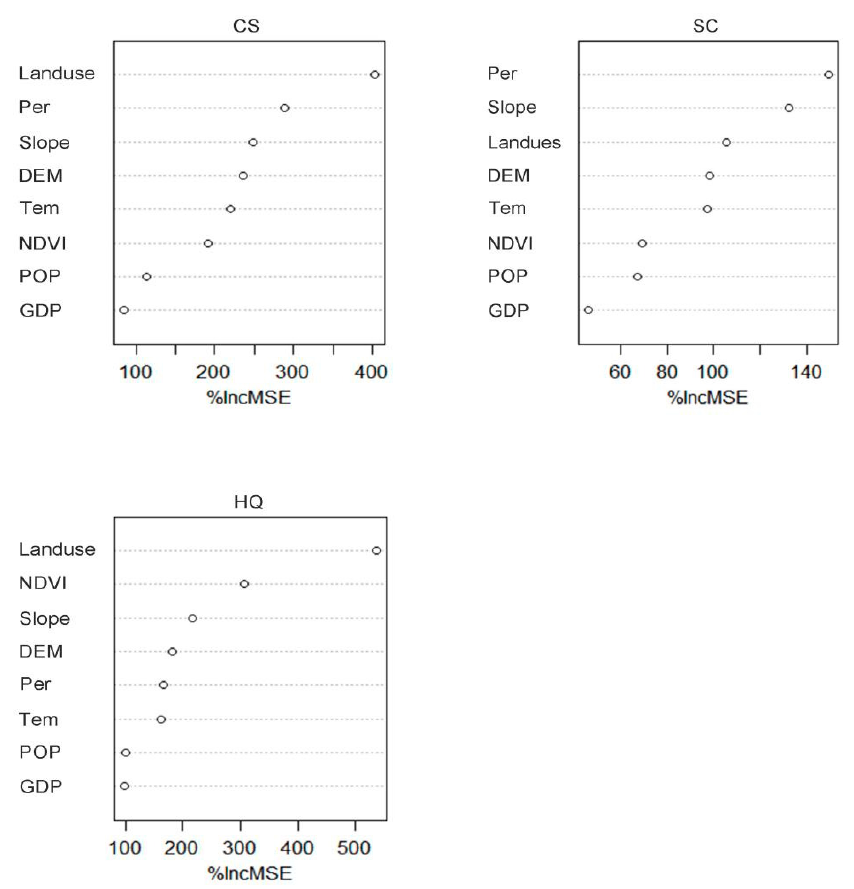
Figure 7. Impact factors and degree of impact of various ESs (Per: precipitation, Tem: temperature, POP: population density, GDP: gross domestic product).